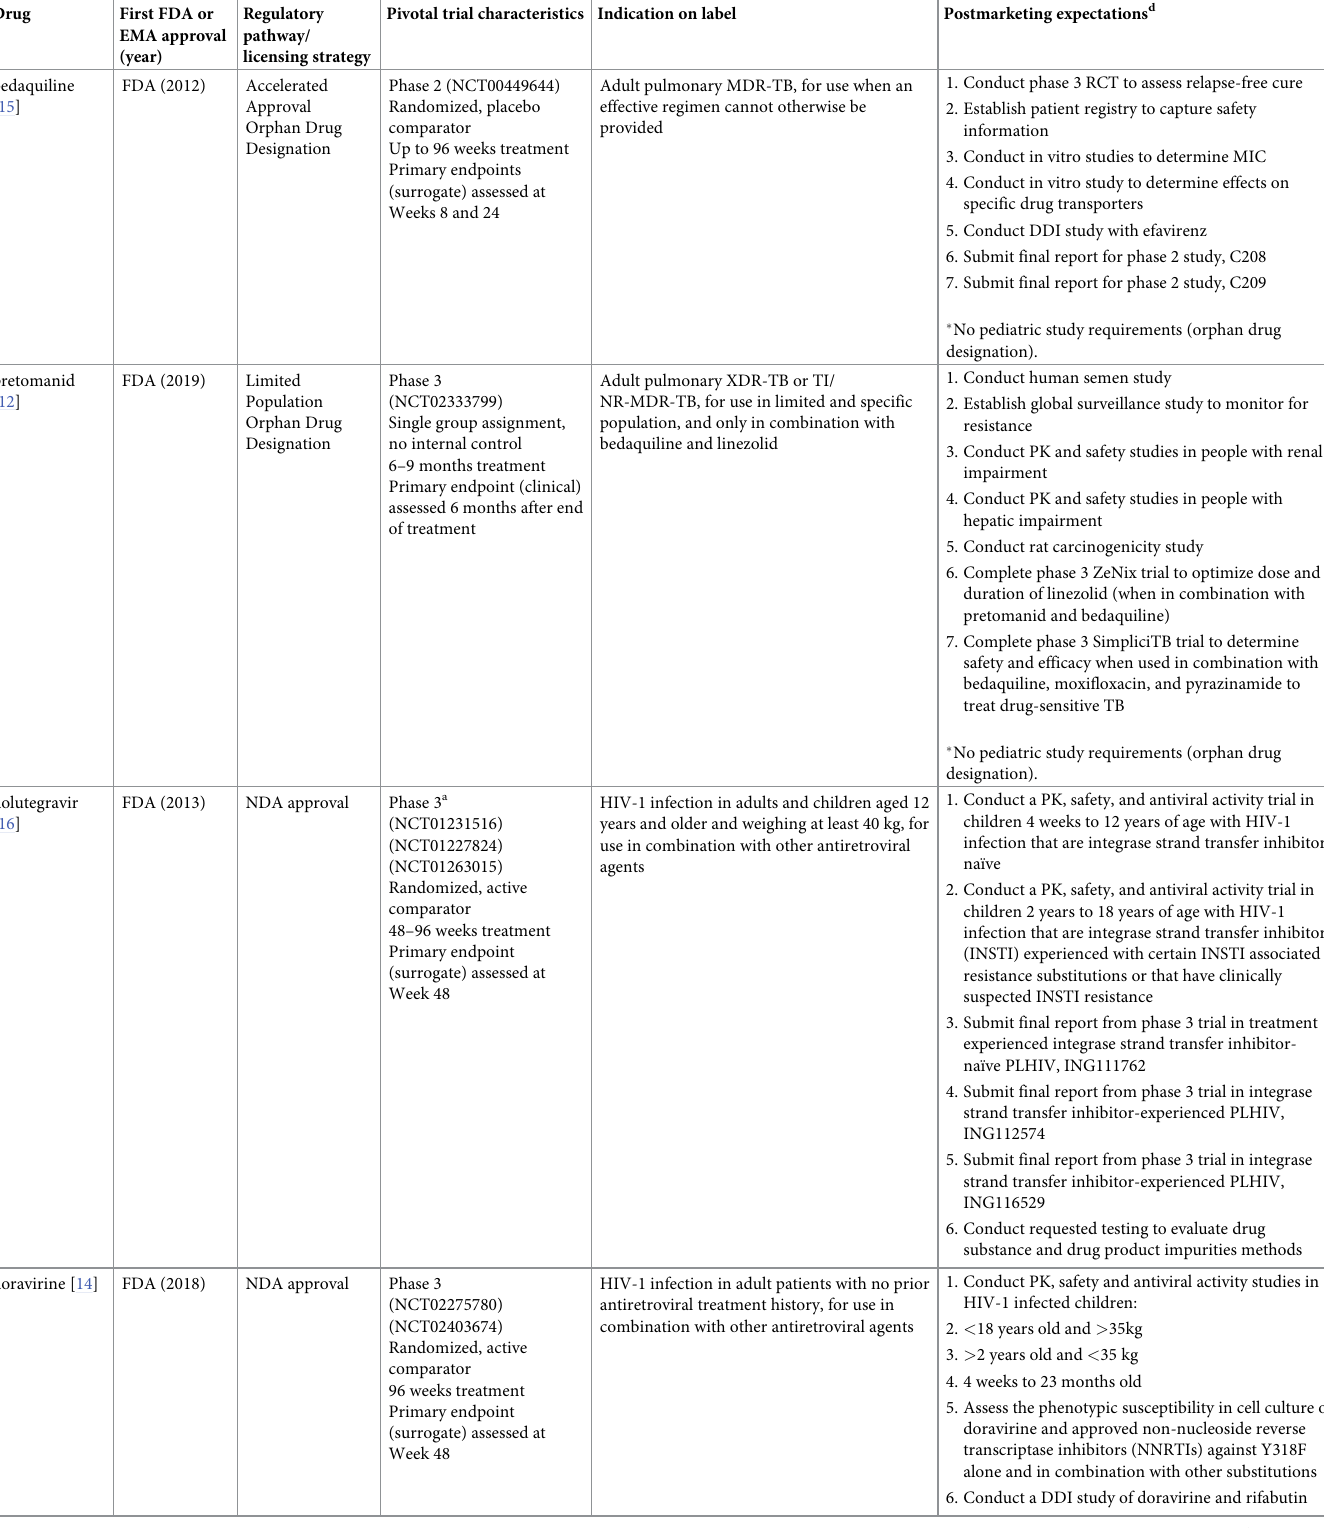
Table 1. Regulatory pathways, study characteristics of pivotal clinical trials, and postmarketing expectations for selected TB, HIV, and HCV